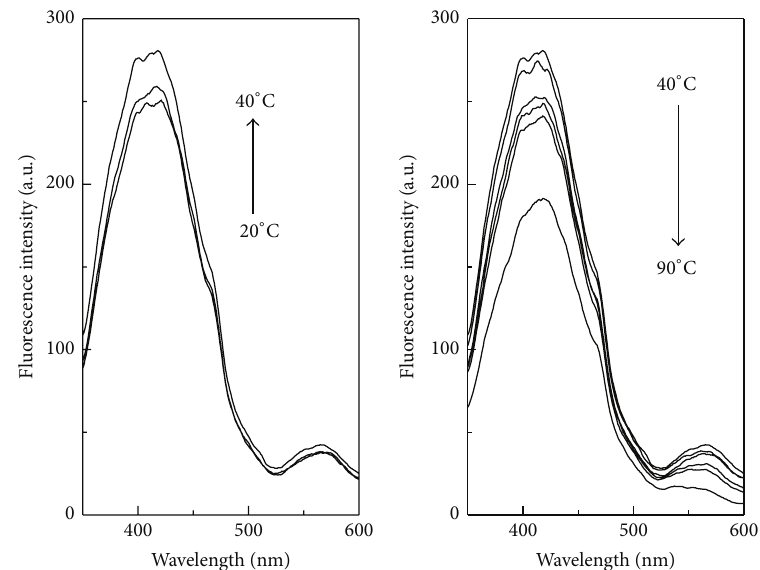
Figure 9: The fluorescence spectra of WPU-CFBB under different temperature under 325 nm excitation.